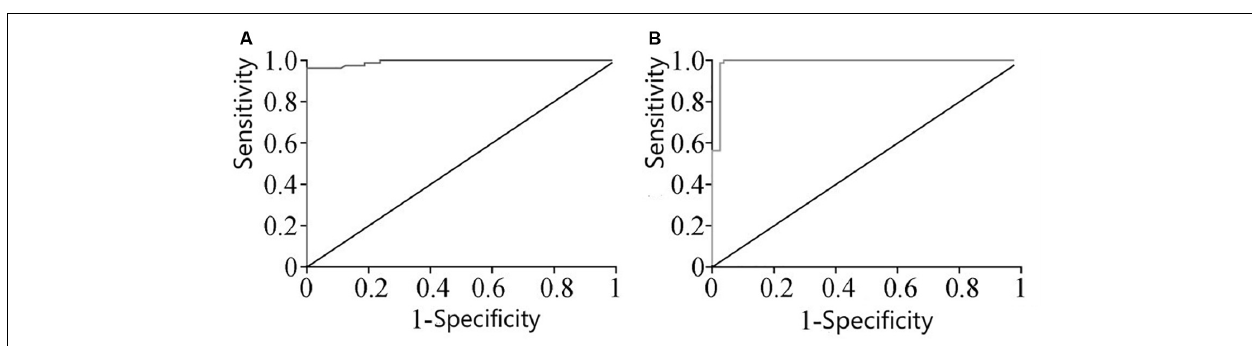
Frontiers in Genetics |